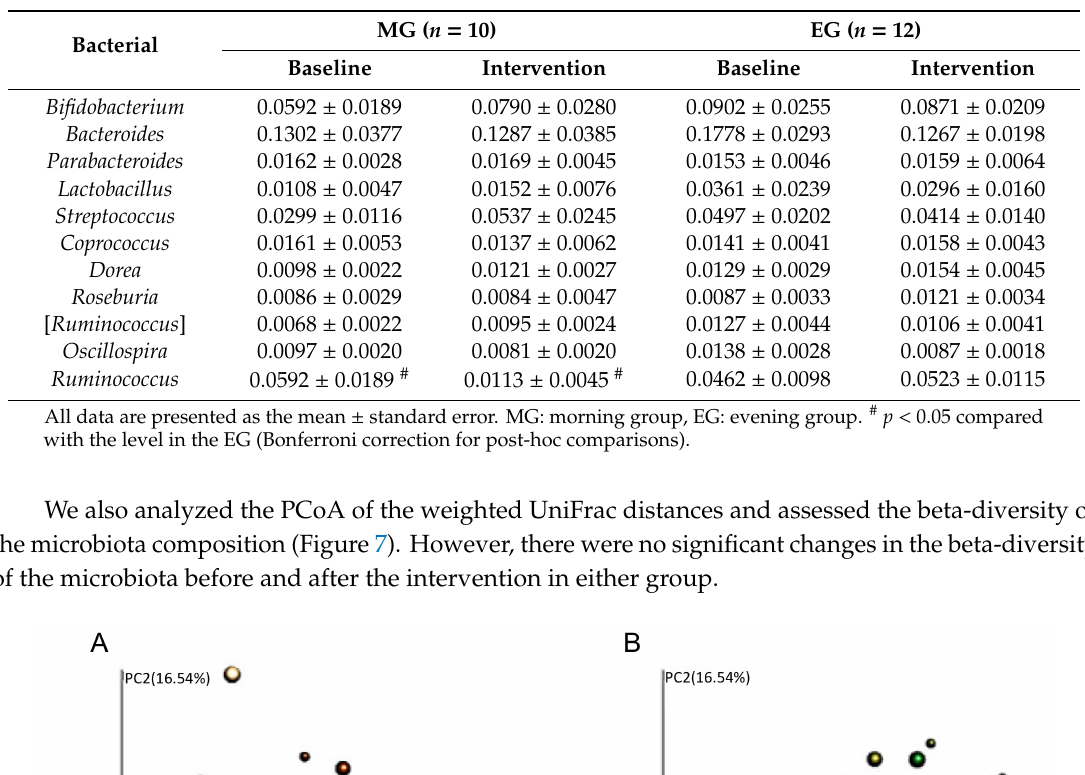
Table 3. Changes in the relative abundance of some bacteria in both groups (genus level).